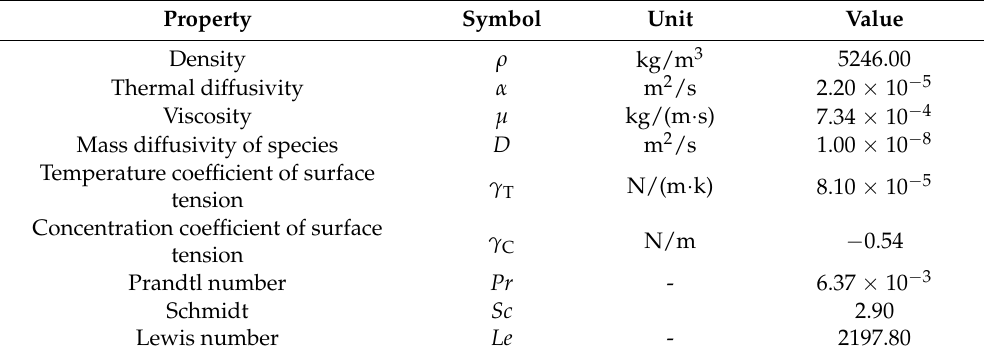
Table 1. Physical parameters of Ge 0.98 Si 0.02 melt.